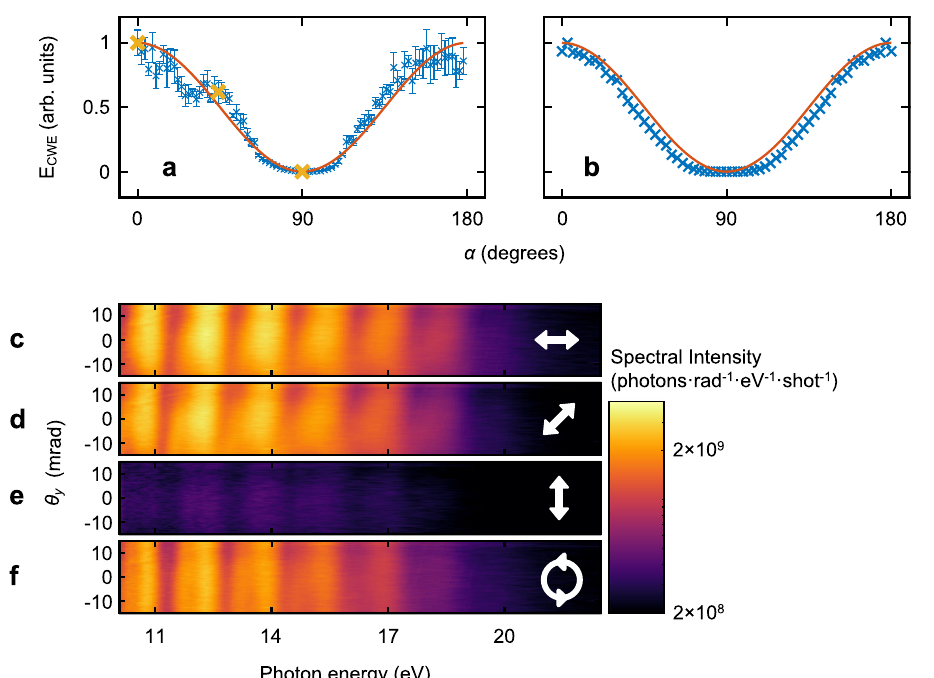
Fig.2|PolarisationdependenceofCWEgeneratedfromaliquidplasmamirror. a , b Polarisation angle ( α ) dependence of CWE spectral intensity obtained in experiments ( a ) and 2D PIC simulations ( b ). The p-polarisation corresponds to α =0 (cid:3) ,andthes-polarisationcorrespondsto α =90 (cid:3) .Thedatapoints(bluecrosses) and error bars show the mean values and standard deviations of 5 independent